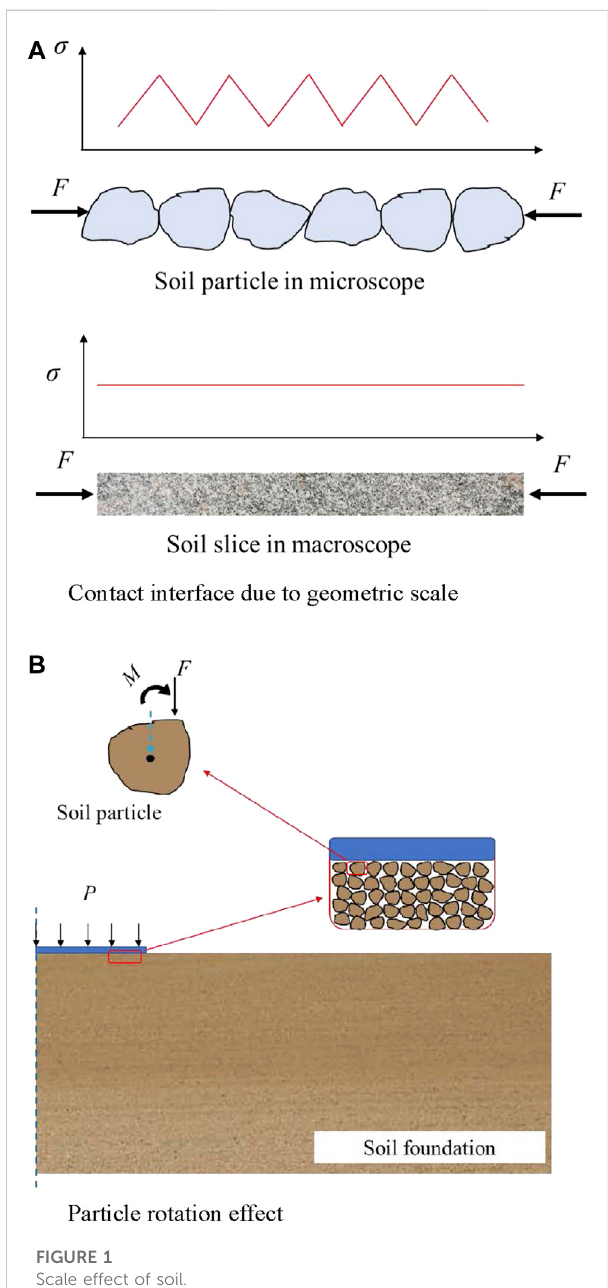
FIGURE 1 Scale effect of